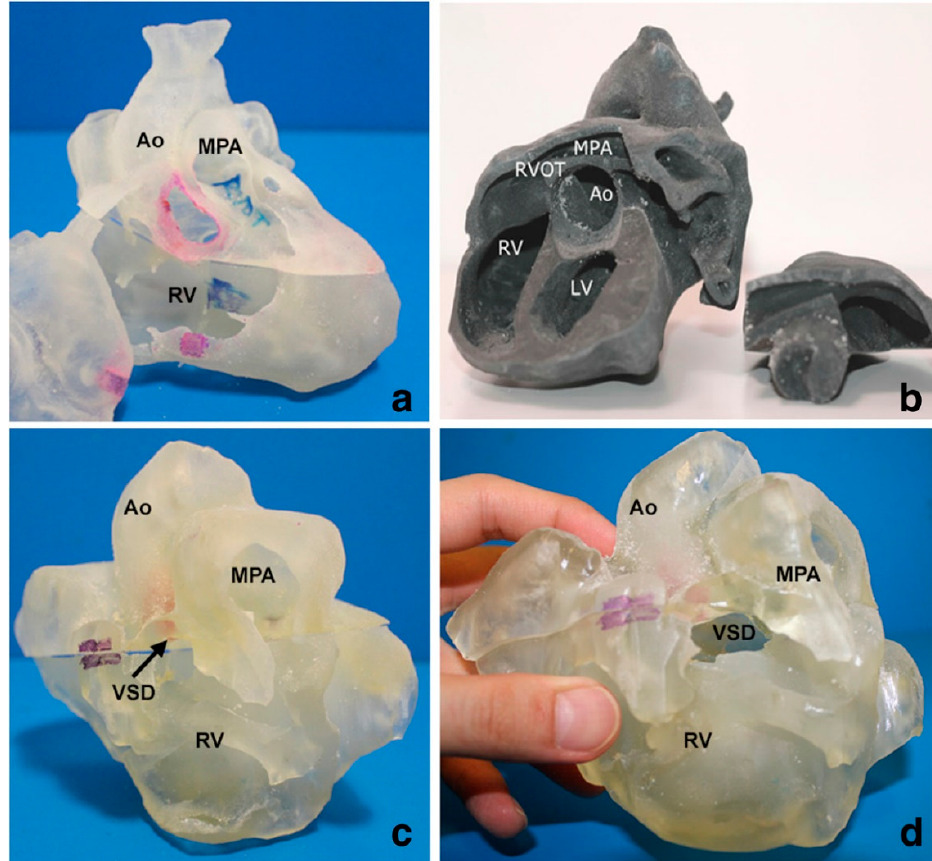
Figure 4. 3D printed heart models showing normal anatomy and pathology. ( a ) Normal heart model created from cardiac CT and is partitioned into three pieces allowing visualization of interventricular septum. ( b ) Repaired Tetralogy of Fallot (ToF) from an adult patient. The model was created from cardiac magnetic resonance imaging (MRI) and separated into two pieces allowing for clear visualization of overriding aorta and pulmonary infundibular stenosis. ( c ) Unrepaired ToF heart model from an infant. The model was created from 3D echocardiographic images and partitioned into two pieces showing the ventricular septal defect (VSD). ( d ) Unrepaired ToF heart model from an infant with superior and inferior portions showing VSD and the aortic overriding in relation to the VSD. Reprinted with permission under the open access from Loke et al. [22]. Ao—Aorta; MPA—Main Pulmonary Artery; LV—Left Ventricle; RV—Right Ventricle; RVOT—Right Ventricular Outflow Tract; VSD—Ventricular Septal Defect; ToF—Tetralogy of Fallot.